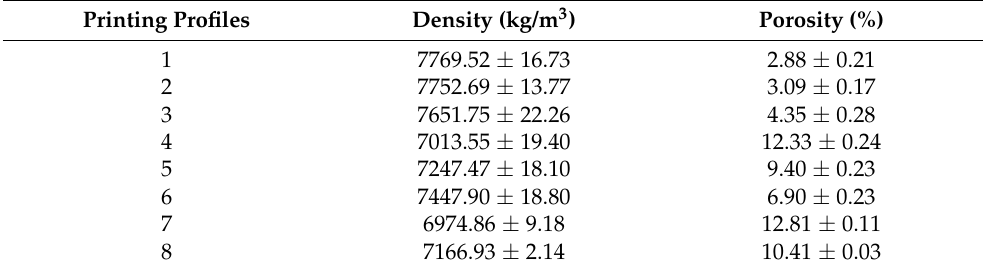
Table 5. Average density and porosity of the bending samples.